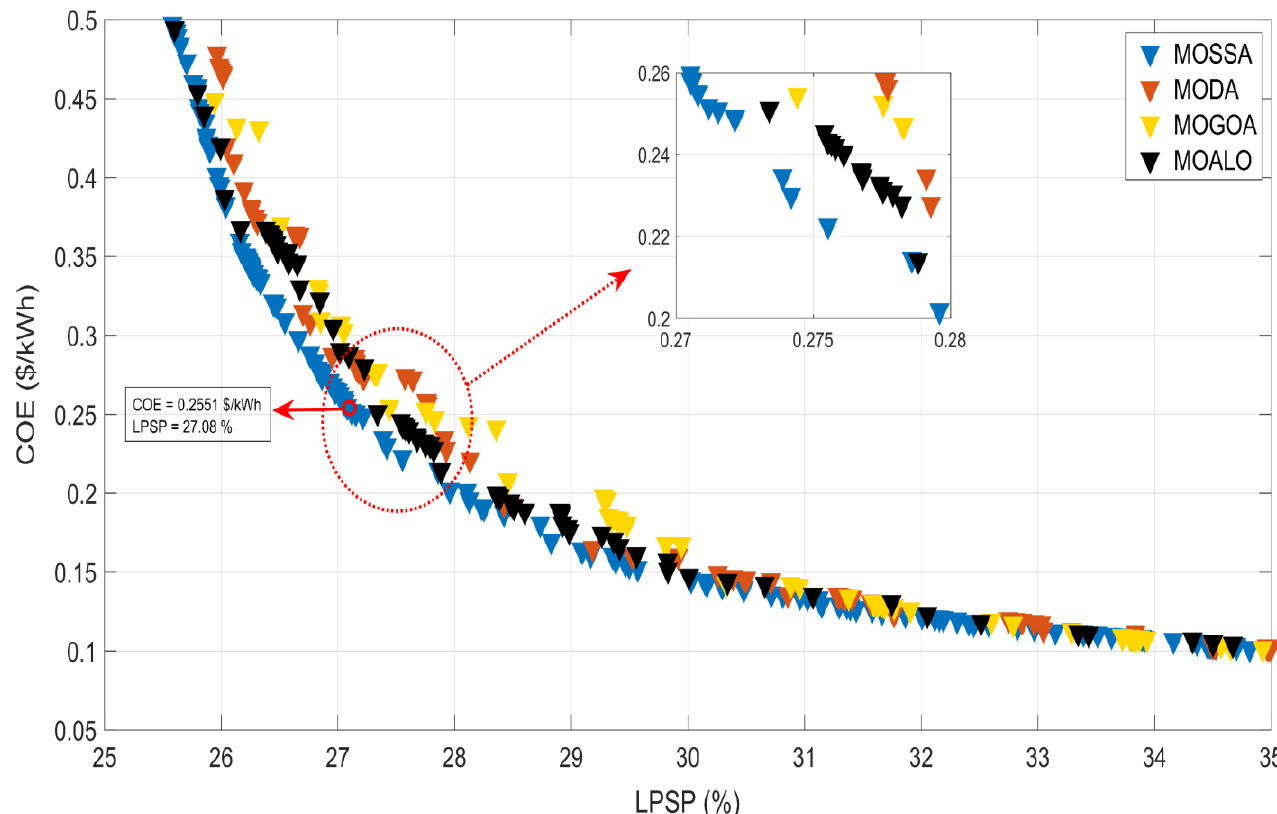
Figure 17. Pareto front of stand-alone microgrid system considering LPSP and COE obtained by MOSSA, MODA, MOGOA, and